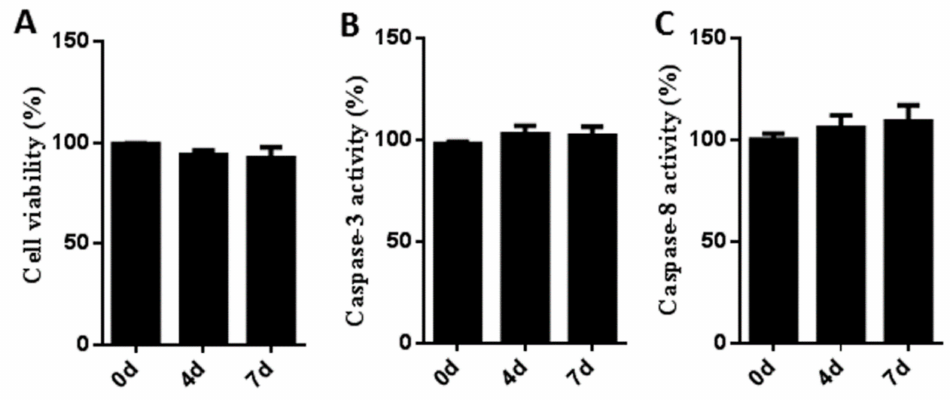
Figure 2. Cytotoxicity and stress e ff ects of SB216763 on muscle satellite cells ( A ) The cytotoxicity of SB216763 on muscle satellite cells was measured by CCK-8 assay. Cells were seeded into a 96-well plate in growth medium with or without 10 µ M SB216763 for 0, 4 and 7 days, respectively. Error bars represent the SEMs of three separate experiments. ( B , C ) The activities of caspase-3 and caspase-8 were measured by the absorbance at 405 nm using a microplate reader (Thermo Fisher, DE, USA). Error bars represent the SEMs of three separate experiments. Quantitative values are expressed as percentages of values from cells treated with SB216763 compared with the same treatment times in untreated control